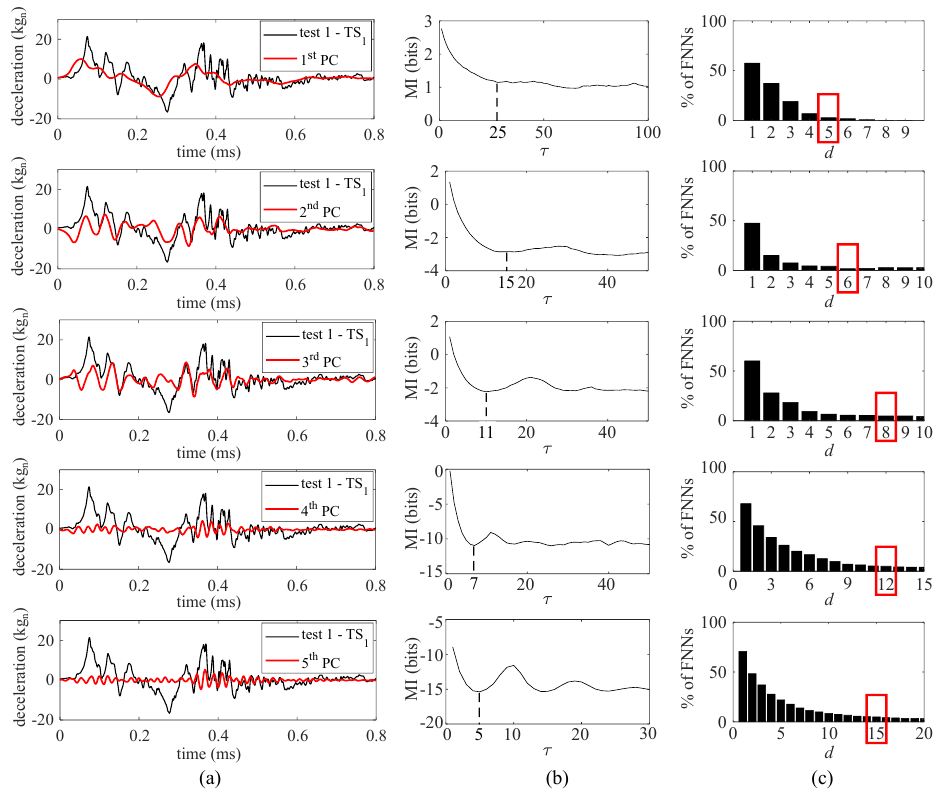
Figure 7. Selection of input space hyper-parameters: ( a ) PCA decompositions of the source domain measurements; ( b ) selection of τ based on MI analysis for each PC decomposition; and ( c ) selection of d based on percentage of FNNs for each PC